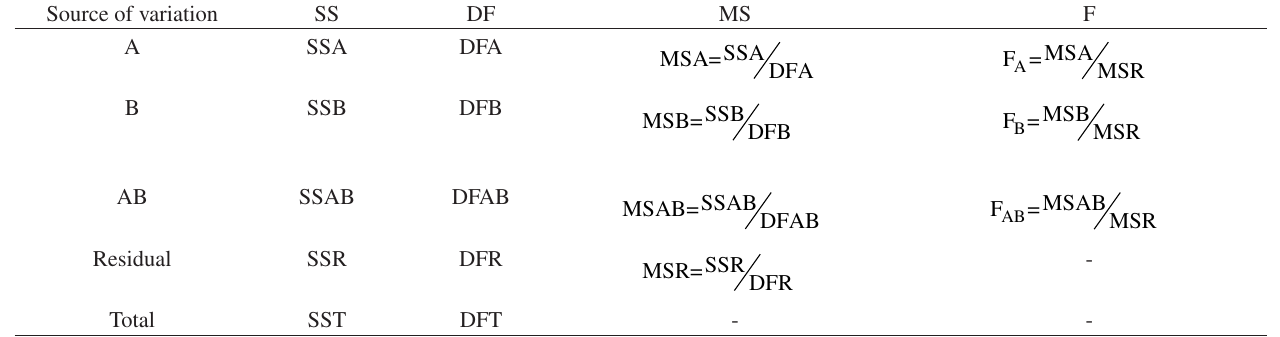
Table 3. ANOVA of the Factorial design 2 2 . Source of